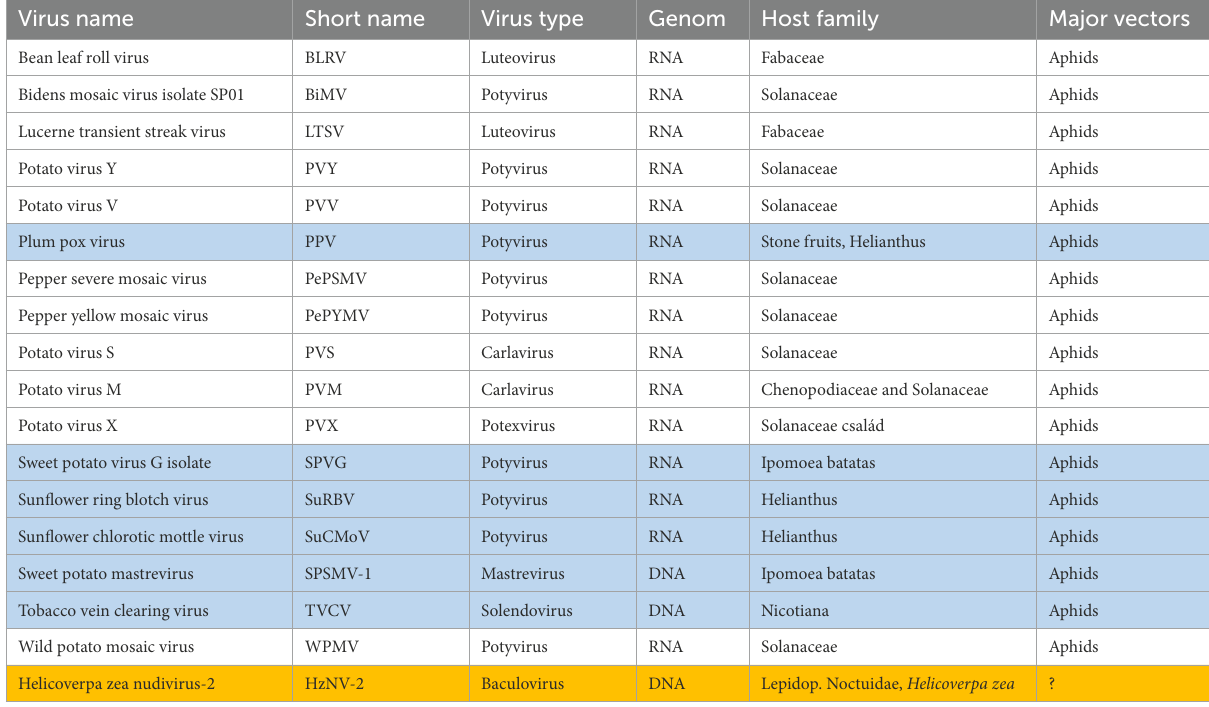
TABLE 2 Plant viruses detected from Canadian goldenrod and crop